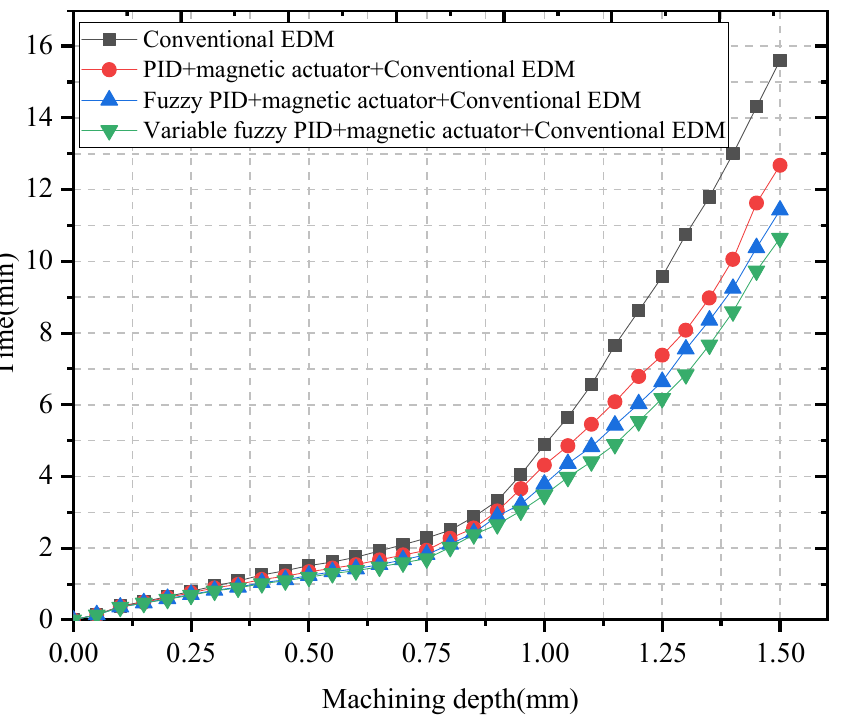
Figure 13. Relationship between micro EDM depth and machining time.